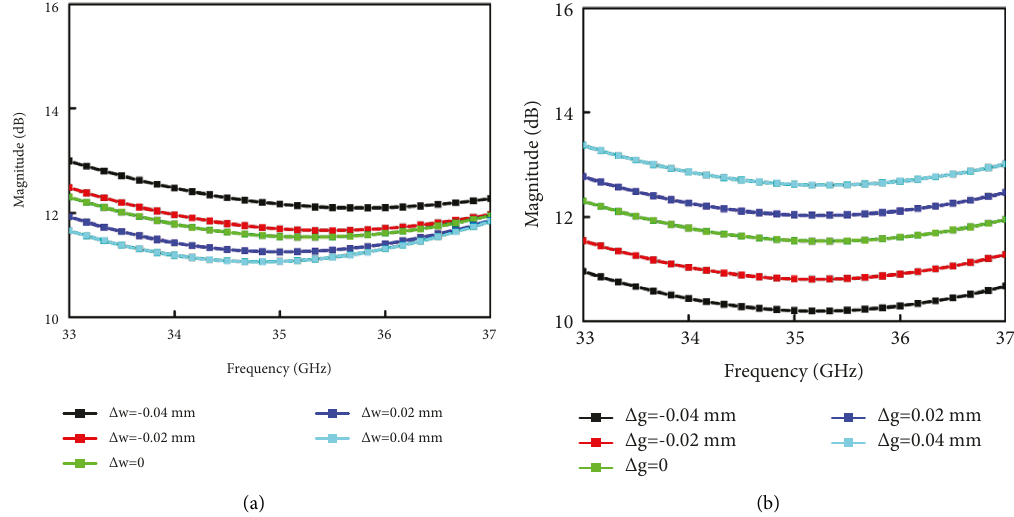
Figure 6: (a) Variation of division ratio with line width error Δ w . (b) Variation of division ratio with spacing error Δ g .